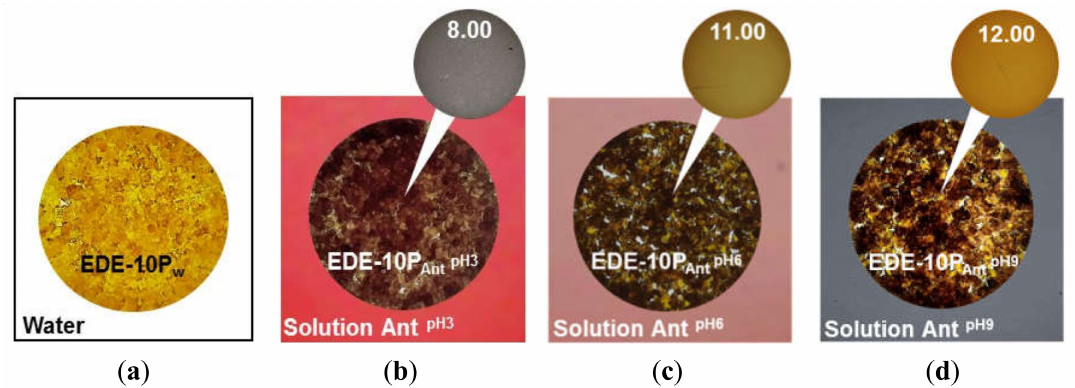
Figure 6. Color of the anion-exchange resin EDE-10P in the Cl − form, equilibrated with deionized water ( a ) and model anthocyanin solutions at pH 3 ( b ), 6 ( c ), and 9 ( d ). The upper circles represent the closest anthocyanin color in solution on the colorimetric scale (Figure 4); the number inside the circle indicates the pH value corresponding to that color of the